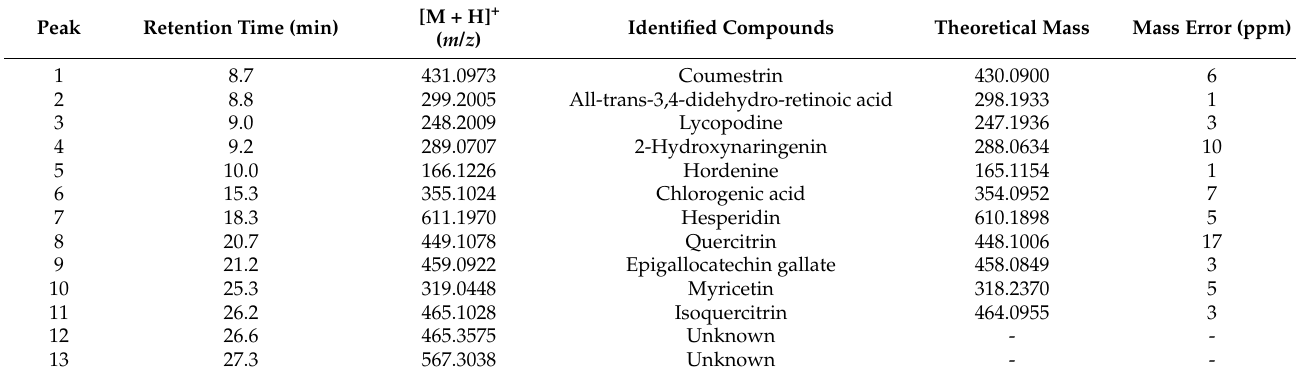
Figure 6. LC-MS profile of GLE. The total ion chromatogram was obtained by a triple quadrupole mass spectrometer operated in the positive electrospray ionization mode. Table 4. Compounds identified from the chromatogram of